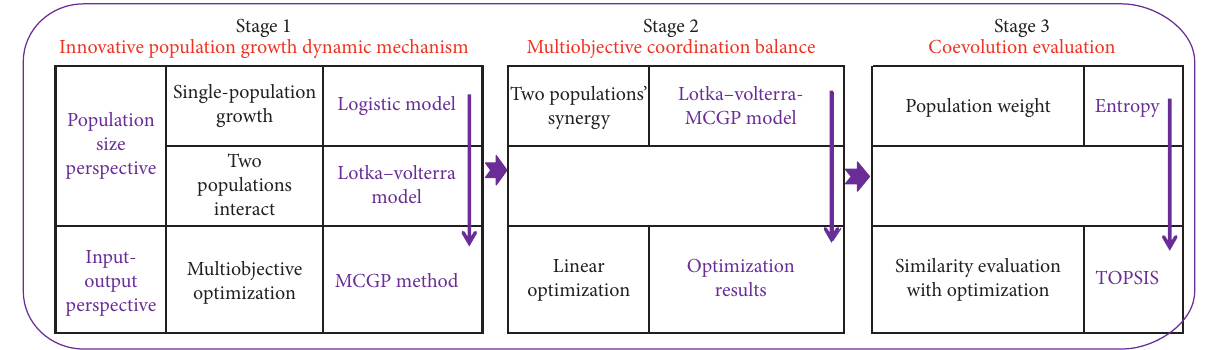
Figure 1: Three-stage multiobjective collaboration evaluation